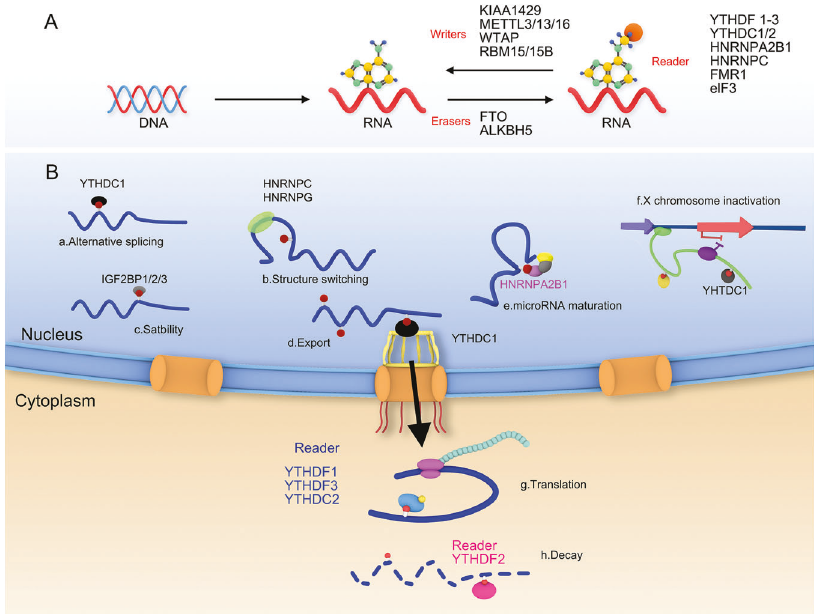
Fig. 1 m6A methylation modi fi cation. A The methylation modi fi cation process of m6A is reversible and requires the participation of methyltransferases, demethylases and methylation reading proteins. Methylase including METTL3/13, WTAP, RBM15 etc. The main role is to catalyze the m6A modi fi cation of adenylate on mRNA. Demethylases, including FTO and ALKHB5, are used to demethylate bases that have undergone m6A modi fi cation. The main function of reader proteins including YTHDF1/2/3, YTHDC1/2 etc. is to recognize bases with m6A modi fi cation, thereby activating downstream regulatory pathways, such as RNA degradation, miRNA processing, etc. B The molecular biological function regulated by m6A methylation modi fi cation, including alternative splicing, structure switching, stability, export, microRNA maturation, X chromosome inactivation, translation and mRNA decay